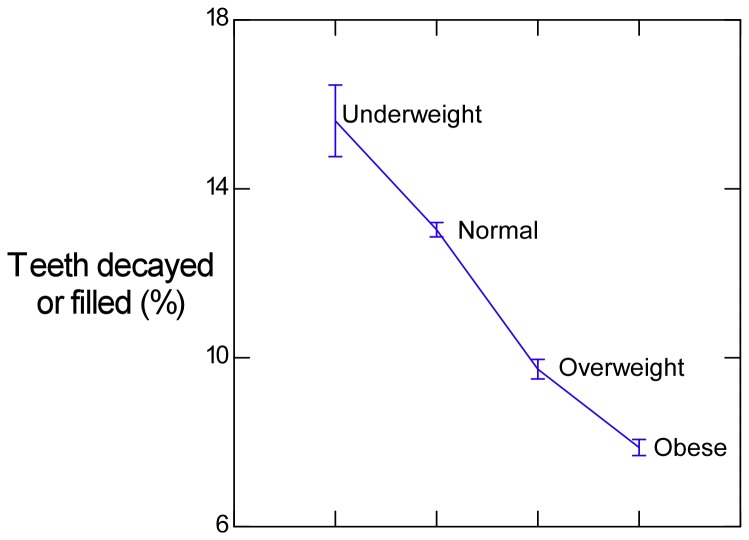
Extent of dental decay (including both primary and permanent teeth) by body weight category (male and female children combined).Plotted values are means and whiskers are SEM.